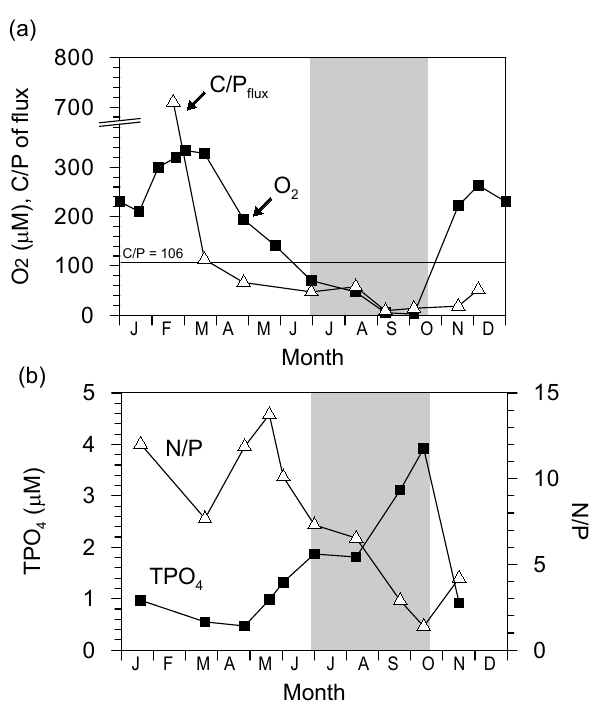
Fig. 7. (a) Oxygen concentrations (from Fig. 2c) and the stoichiom- etry of the TCO 2 to TPO 4 flux (C/P) by molecular diffusion at the sediment–water interface calculated using the measured data. The horizontal black line is the Redfield C/P ratio (106). Note the axis break in the ordinate. (b) TPO 4 concentrations and dissolved in- organic nitrogen to phosphorus atomic ratios (N/P) in the bottom water over the study period (data from Bange et al., 2011). The pe- riod with hypoxic bottom water (O 2 < 63µM) is indicated with the grey shaded